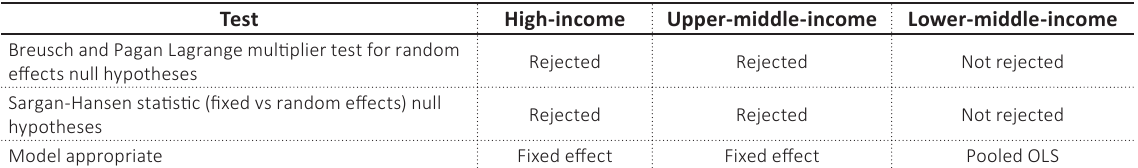
Table А2. Breusch and Pagan Lagrange multiplier test for random effects and Sargan-Hansen statistic